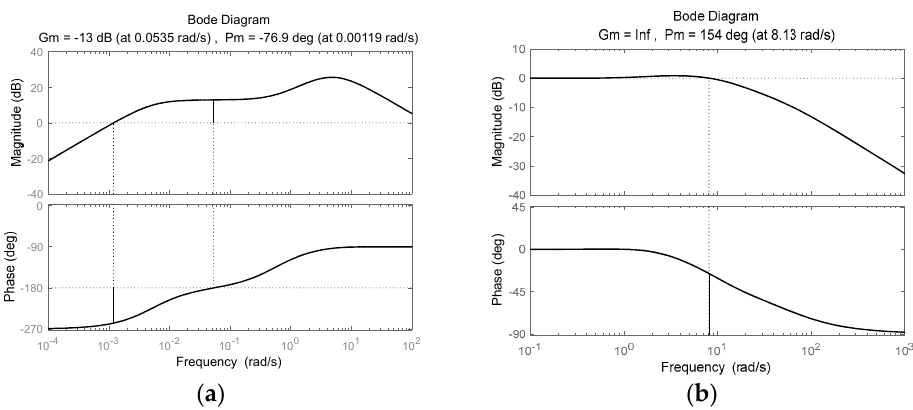
Figure 6. Bode diagrams of the model at the feature point: ( a ) Open loop bode diagram. ( b ) Close loop bode diagram under PID control.